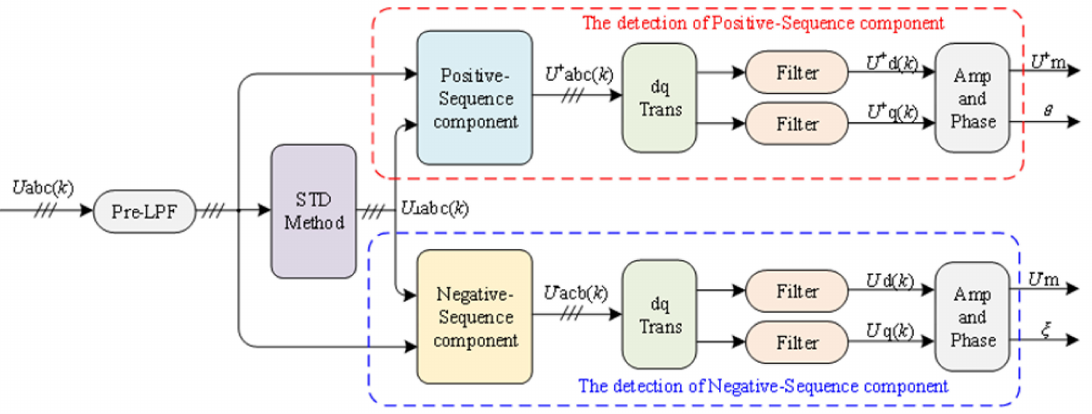
Figure 1. The schematic diagram of the three phase unbalanced voltage sag drop detection algorithm.